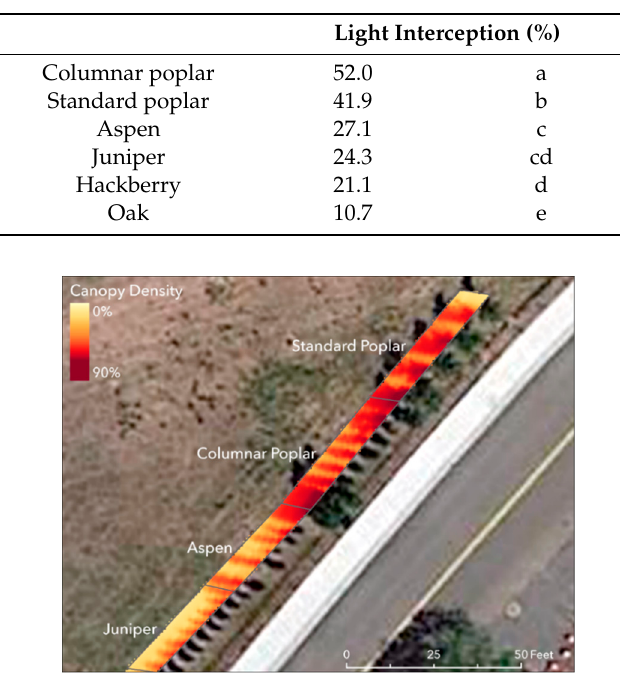
Figure 3. Density in the bottom 3 m of the canopy as measured by light interception. Spatial variability in light interception is shown superimposed on a satellite image (Google Earth) of part of the study area. The satellite image was not taken at the same day or time as the light interception measurements.